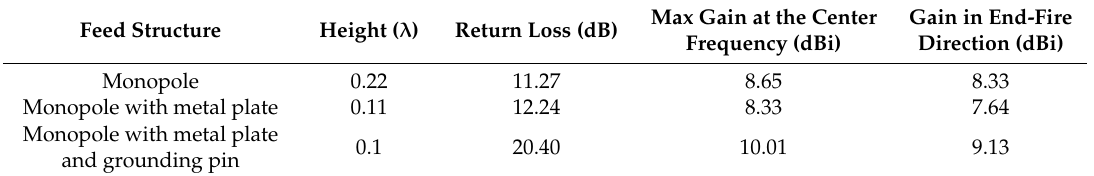
Table 1. Key parameters of the antenna with di ff erent feed structures.